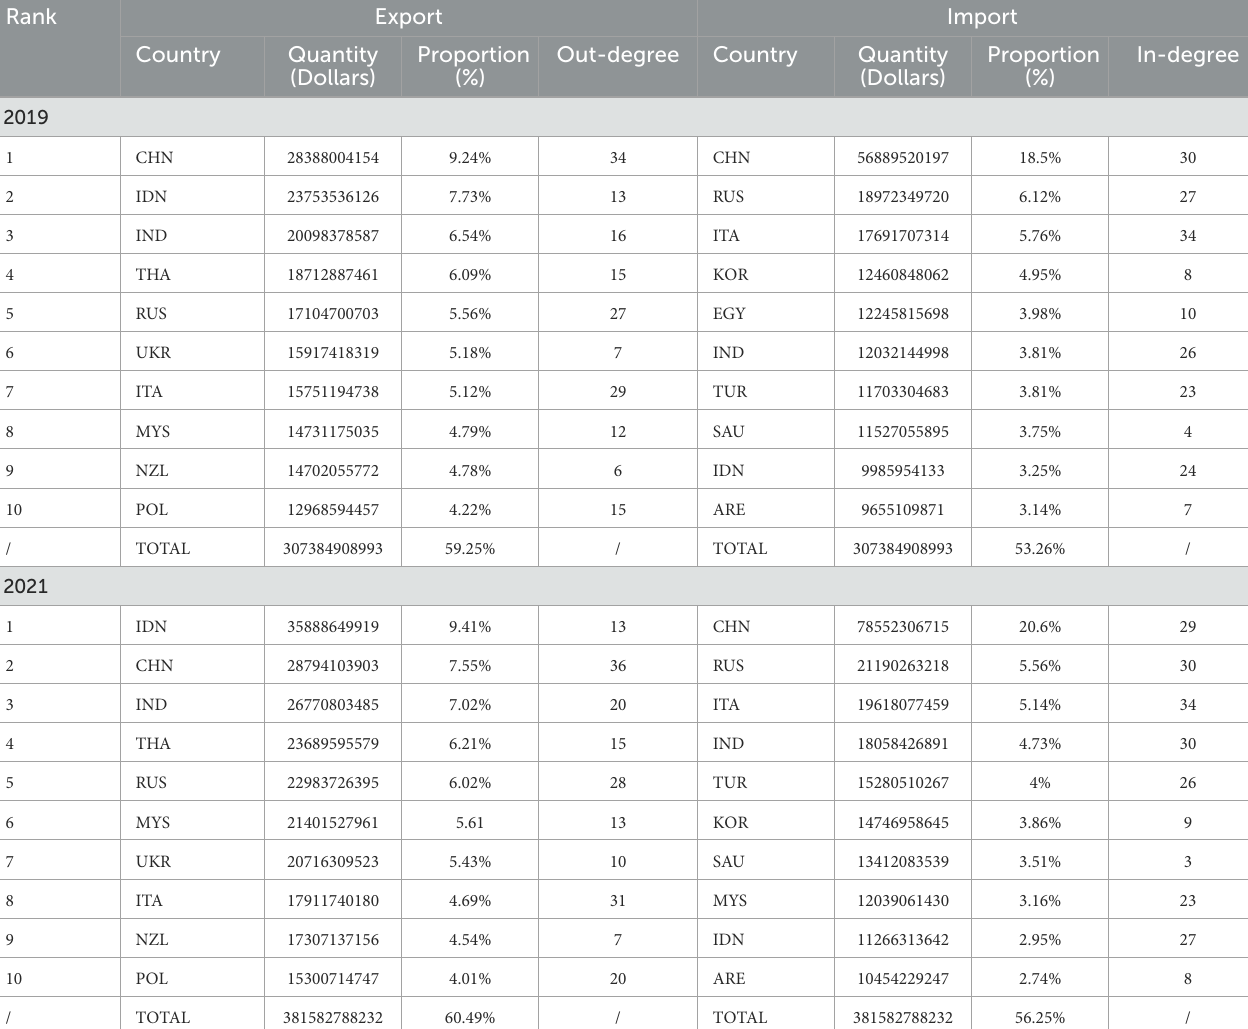
TABLE 3 Characteristic of the Agricultural product exporting and importing nations worldwide in 2019 &